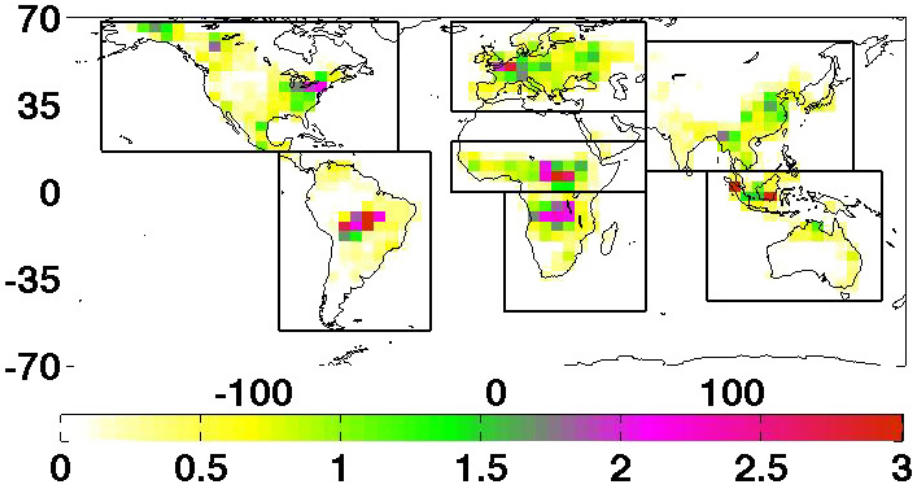
Figure 4. Distribution of emissions used for the idealized 30-day tracer. The unit is 10 13 moleccm − 2 s − 1